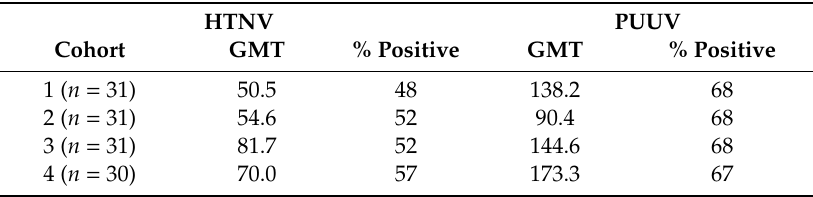
Table 4. Day 84 plaque reduction neutralization test (PRNT)50